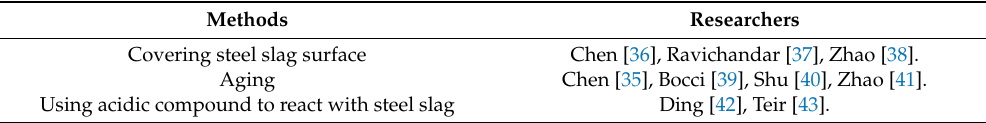
Table 5. The methods to control the volume expansion of steel